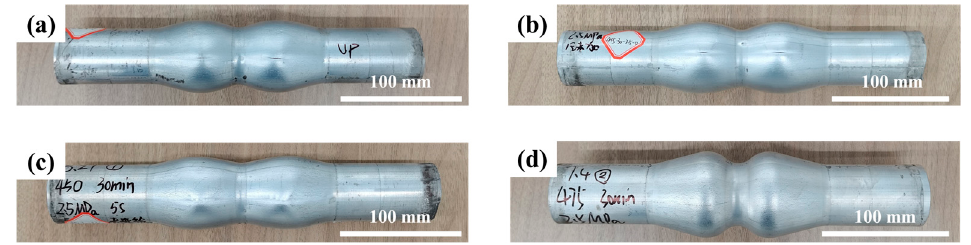
Figure 10. Forming results of parts under different temperatures: ( a ) 400 °C; ( b ) 425 °C; ( c ) 450 °C; ( d ) 475 °C.